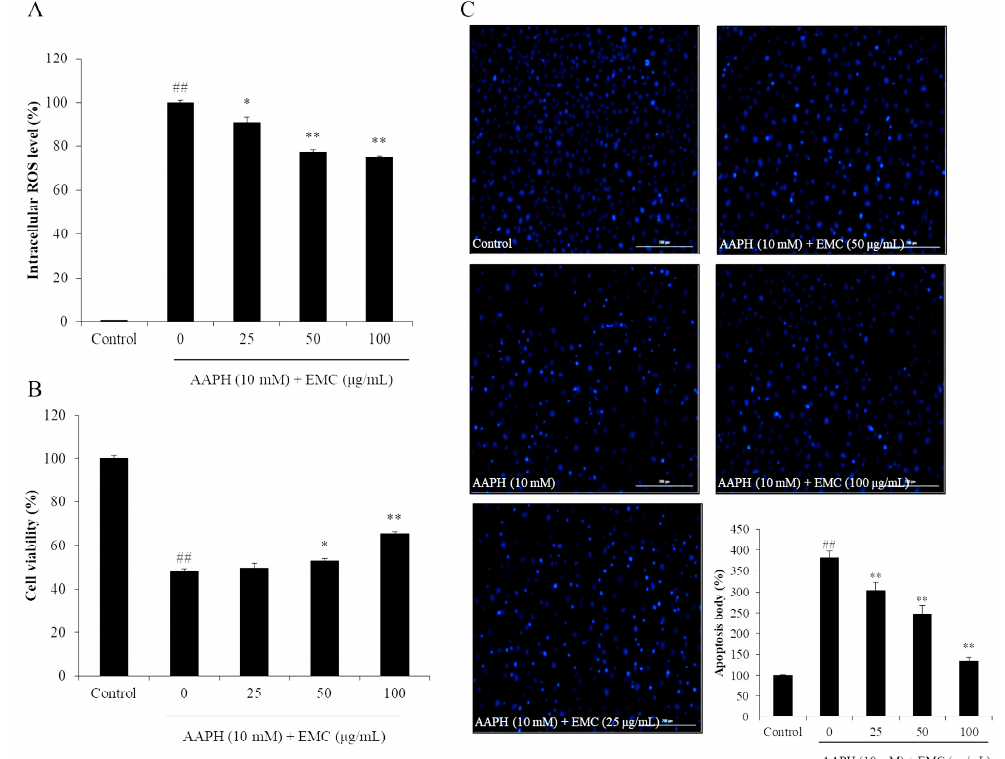
Figure 2. EMC suppresses 2,2-azobis(2-amidinopropane) hydrochloride (AAPH)-induced oxidative damage in vitro in Vero cells. ( A ) Intracellular ROS scavenging e ff ect of EMC in AAPH-stimulated Vero cells; ( B ) protective e ff ect of ECM against AAPH-induced cell death in Vero cells; ( C ) protective e ff ect of EMC against AAPH-induced apoptosis in Vero cells. The intracellular ROS level, cell viability, and apoptotic body formation were evaluated through DCF-DA, MTT, and Hoechst 33342 staining assays, respectively. Apoptosis levels were measured using Image J software. The experiments were conducted in triplicates, and the data are expressed as the mean ± SE. * p < 0.05, ** p < 0.01 as compared to the AAPH-treated group and ## p < 0.01 as compared to the control